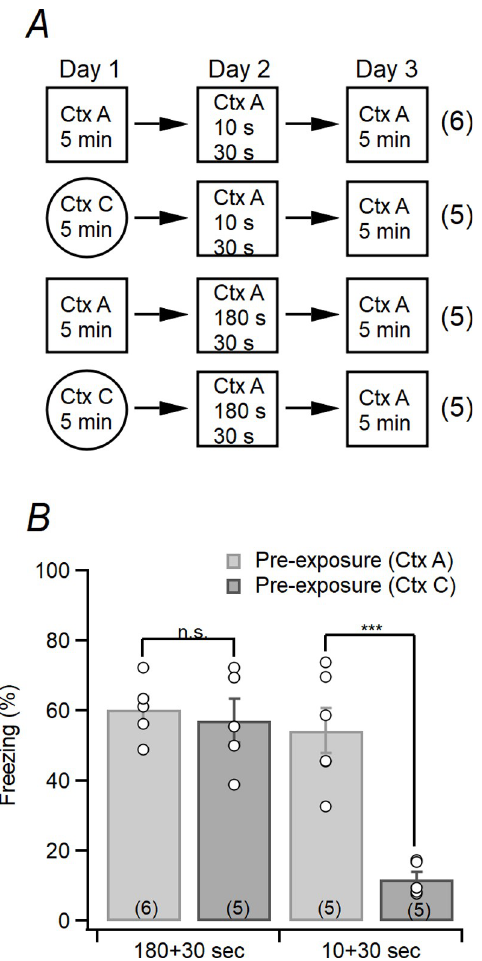
Fig 1. Protocols for pre-exposure mediated contextual fear conditioning (PECFC) and results. (A) Schedule of the PECFC. On the day 1, mice were exposed to either the Ctx A (preexposure) or Ctx C (non-preexposure) for 5 m. On the day 2, the Ctx A group and the Ctx C group were divided into four experimental subgroups according to the place- to-shock interval (10 s and 180 s) as shown in this figure. All mice returned to homecage after 30 s from the shock. On the day 3, freezing of mice was measured during the exposure of Ctx A for 5 m. (B) Based on schedule in the Fig 1A, freezing level of mice exposed to the Ctx A on day 3 was measured (context: F (1,17) = 18.967, p < 0.001; time: F (1,17) = 24.136, p < 0.001; context × time: F (1,17) = 14.122, p = 0.002, GLM).